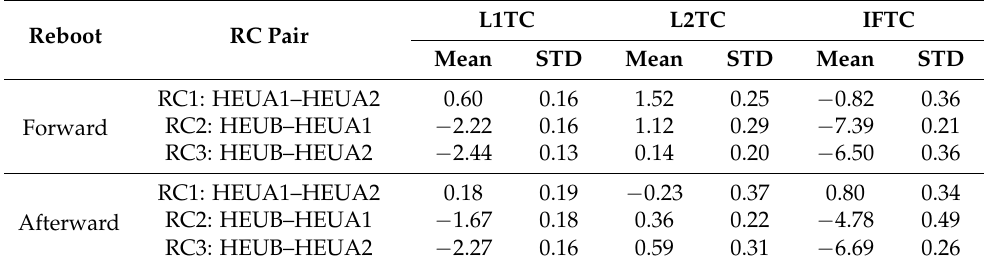
Figure 4. ISB estimations in receiver reboot experiments. The columns from left to right are the L1TC, L2TC, and the IFTC method, respectively. The columns from top to bottom are the ISB estimations of receiver pairs RC1, RC2, and RC3, respectively. Note that the ISB estimations are represented by blue points and the mean of ISB estimations is represented by green points. Table 6. Statistics of ISB estimations in receiver reboot test (m).